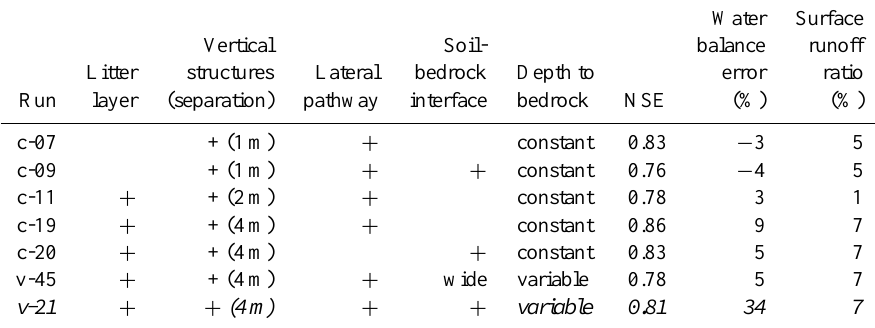
Table 4. Structural features and evaluation criteria of selected model set-ups (“ + ” indicates presence of the respective structural feature): the runs c-07, c-09, c-11, c-19, and c-20 from the basic model set-ups and the run v-45 from the additional model set-ups were acceptable for the hydrograph simulations with a NSE greater than 0.75, a water balance error less than 10%, and surface runoff less than 10% of total outflow during the sprinkling phase (surface runoff ratio); the run v-21 from the basic model set-ups is given for comparison with the modified set-up v-45 with a widened soil–bedrock